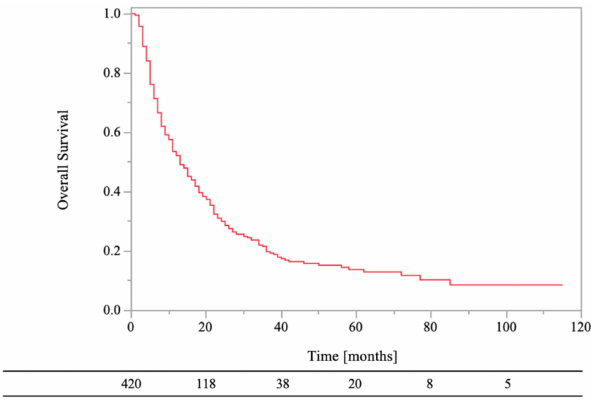
Figure 2. Overall survival of all patients. Table 2. Results of univariate and multivariate analyses for survival rates after